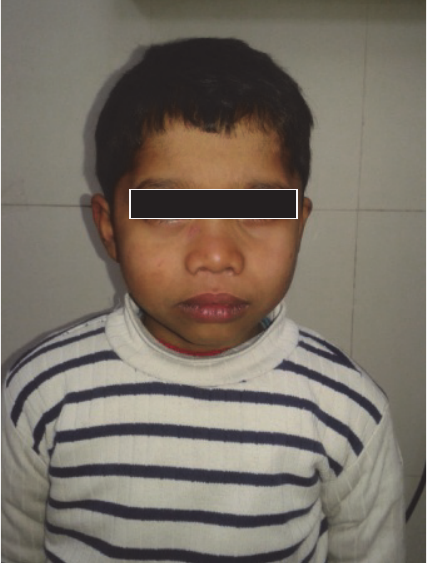
Figure 1: Facial features show midface hypoplasia, depressed nasal bridge, and thick lips.